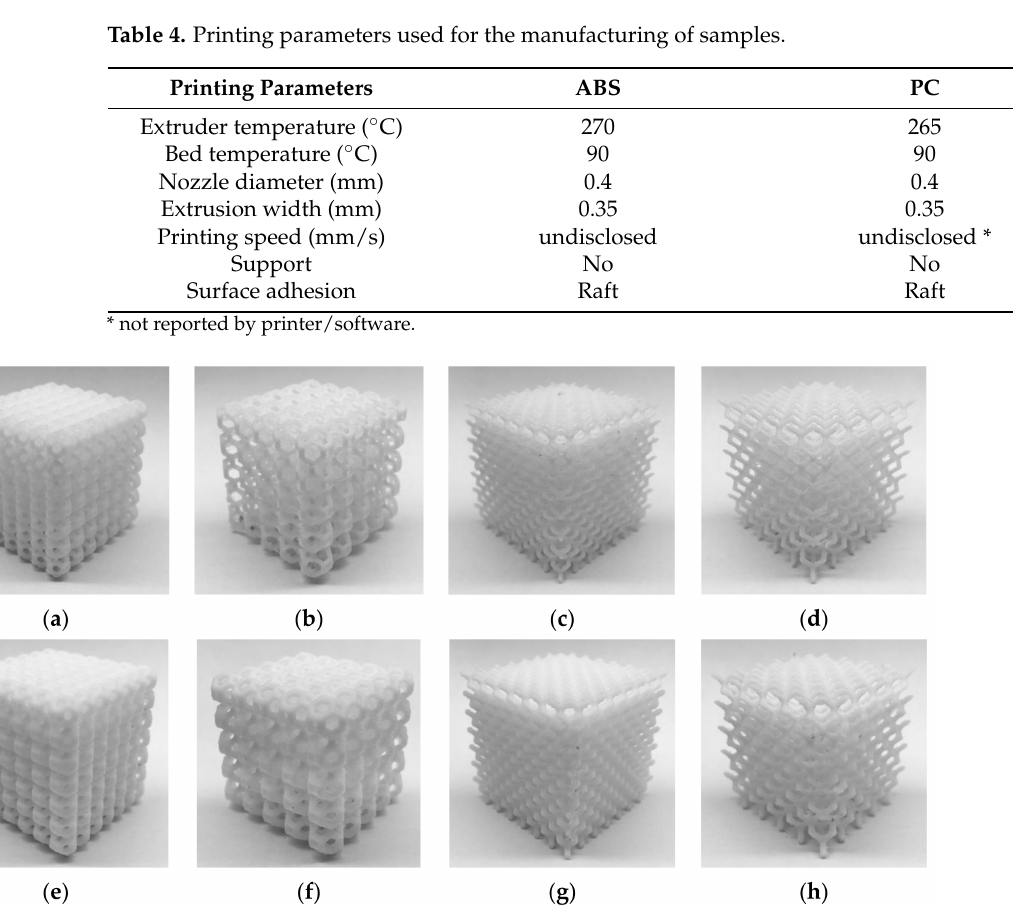
Figure 1. ABS printed specimens ( a ) 001; ( b ); 002; ( c ) 003; ( d ) 004; ( e ) 005; ( f ) 006; ( g ) 007; and ( h )